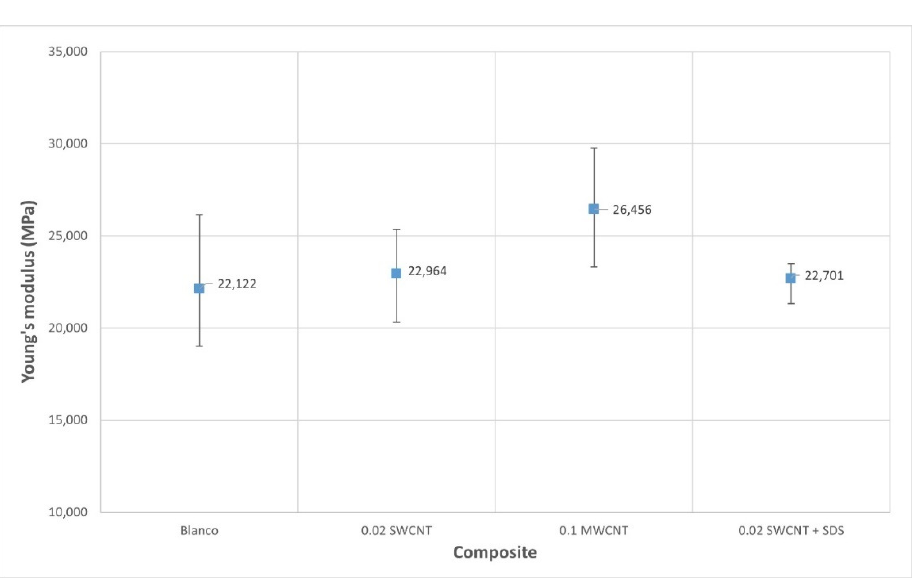
Figure 6. Young’s modulus for each type of composite calculated with (4). Average values and deviation bars. Table 4. Young’s modulus for each type of composite calculated with (4). Mean, maximum, and minimum values obtained from laboratory tests. Deviation calculated in % with respect to the mean